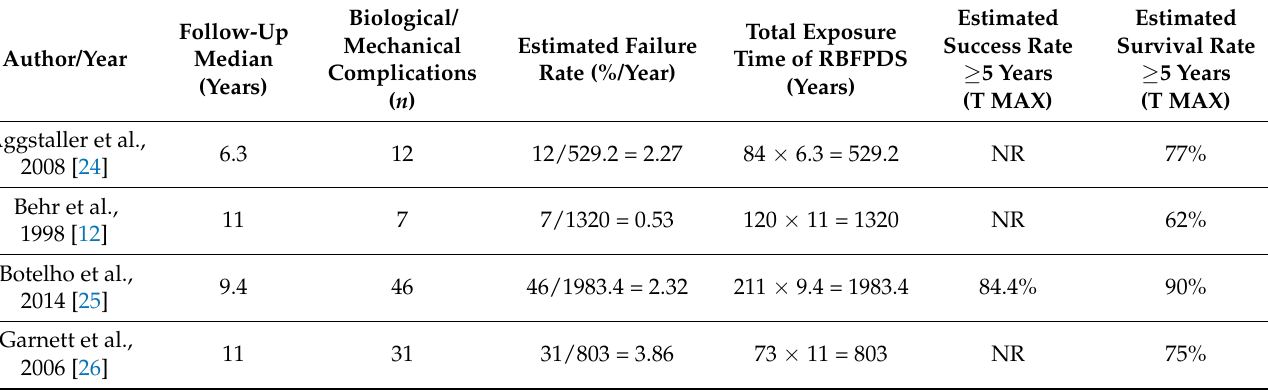
Table 2. Table of data extraction and descriptive analysis of the included